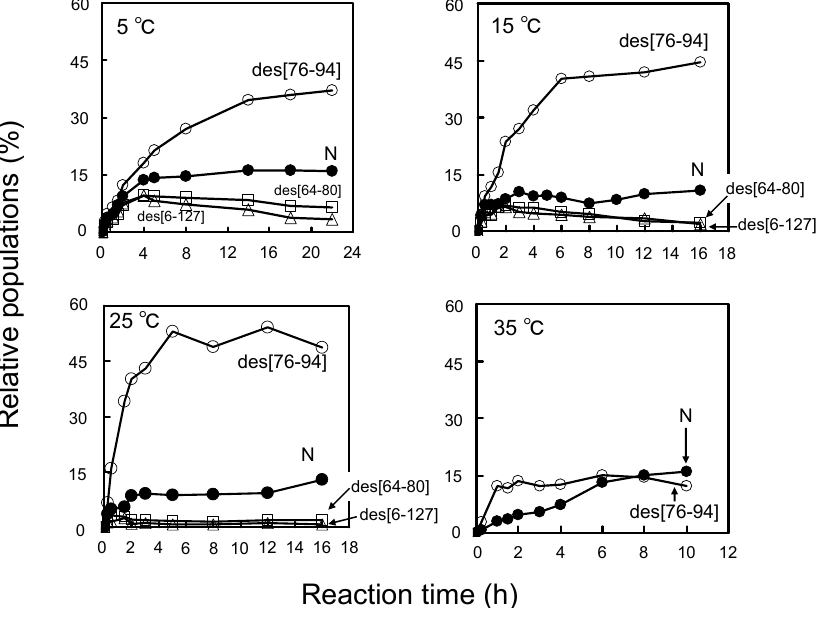
Figure 6. Population changes of the three des intermediates and N as a function of the reaction time at pH 8.0 in the presence of 2 M urea. The populations were estimated by the reduction pulse experiments. Folding conditions were [R] [R] = [DHS ox ] /3 = 11.0 µM at 15 °C, [R] 0 0 = [DHS ox ] /3 = 9.2 µM at 35 °C. The reduction pulse conditions were 6 mM DTT red [R] 0 0 for 3 min at 5 °C and 1 mM DTT red for 2 min at 35